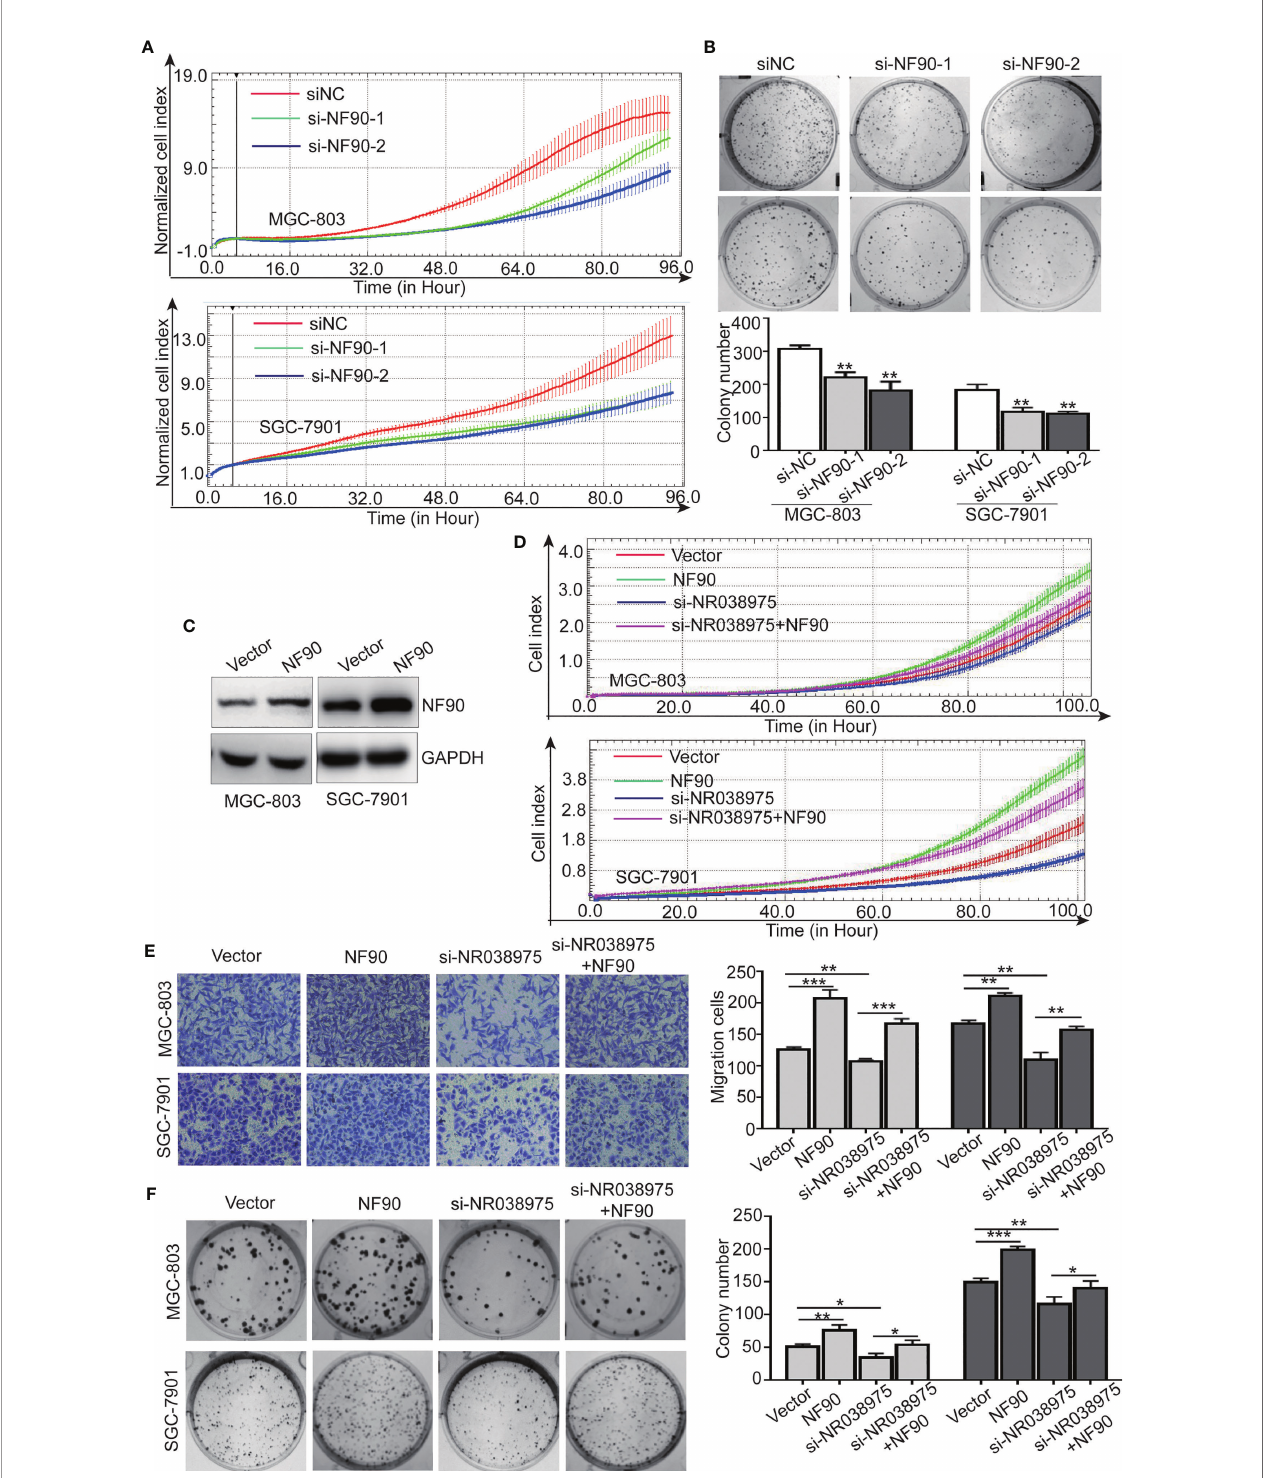
FIGURE 6 | Long noncoding RNA (lncRNA) NR038975 functions through its interaction with NF90. (A) Proliferation of MGC-803 and SGC-7901 cells with knocked down NF90 was assessed by Real-Time Cell Analyzer (RTCA) system. (B) The effect of NF90 knockdown on colony formation in gastric cancer cells was investigated. (C) NF90 expression level was measured through Western blotting after overexpression of NF90. (D – F) Overexpression of NF90 reversed the NR038975 knockdown-reduced growth (D) , migration (E) , and colony formation (F) of MGC-803 and SGC-7901 cells. *p < 0.05, **p < 0.01, and ***p <